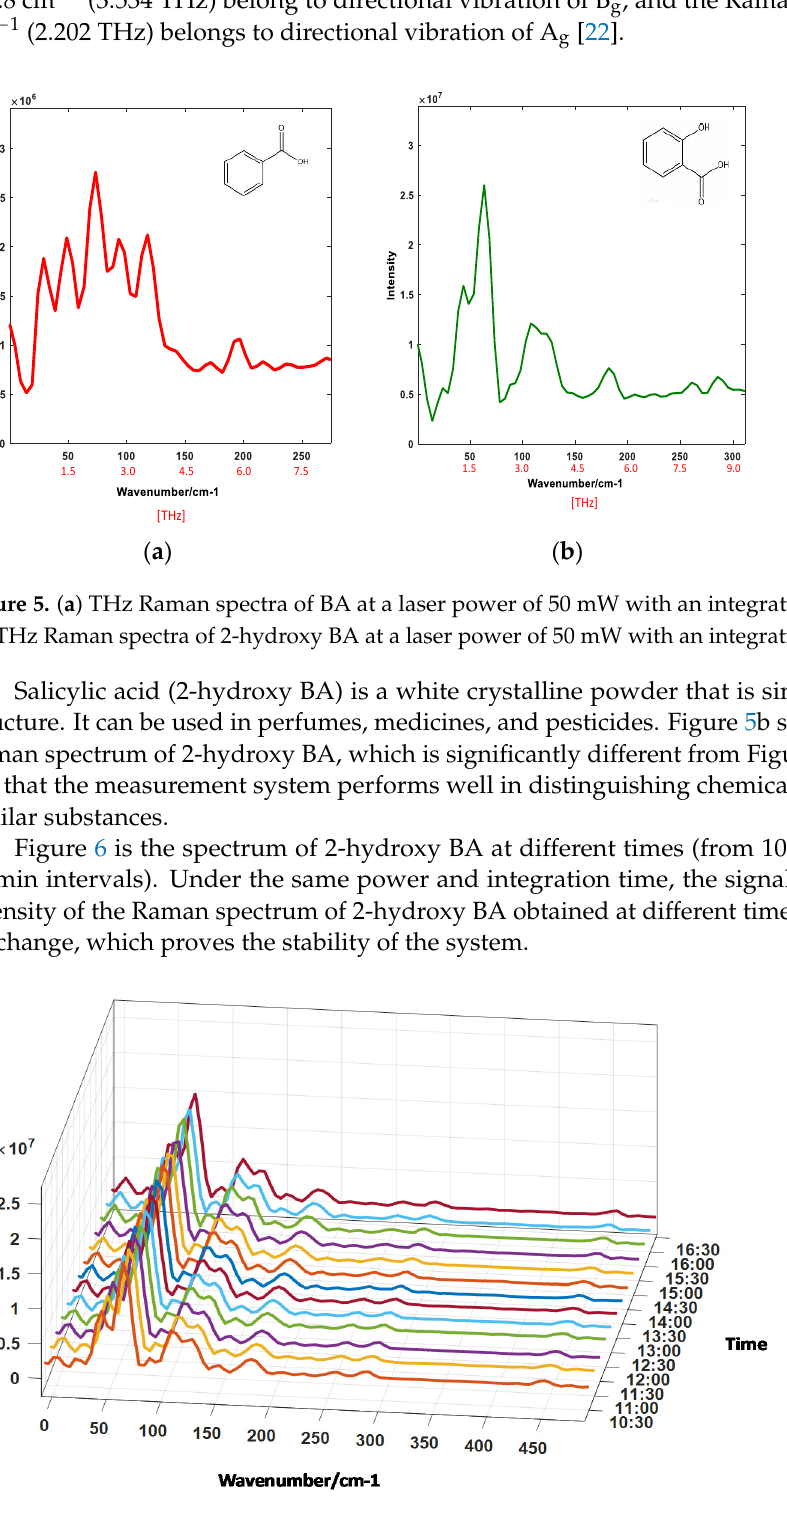
Figure 6. Spectra of 2-hydroxy BA at different times with a laser power of 50 mW and integration time of 20 s.